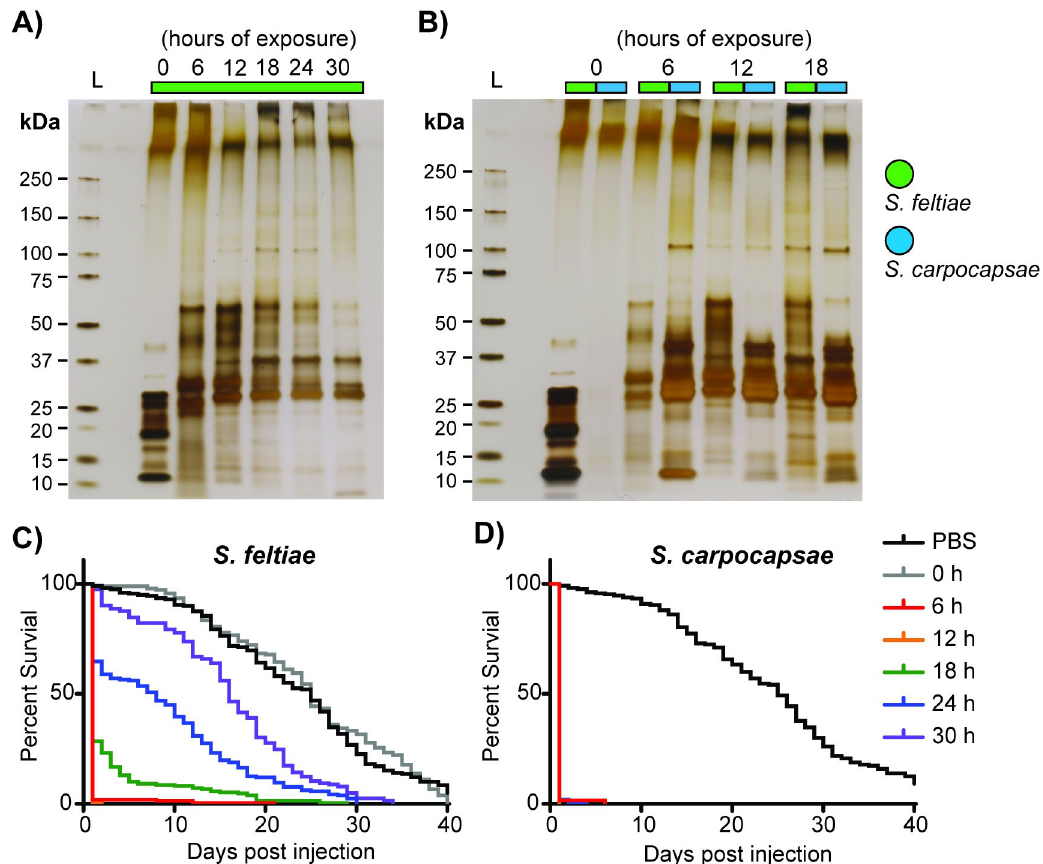
Fig 2. Steinernema IJs release toxic proteins. (A) Silver stained protein gel of whole ESPs collected from S . feltiae IJs activated for 0 (non-exposed), 6, 12, 18, 24, and 30 hours in insect homogenate. All time course activations were done with approximately 2.5 million IJs and the collected ESPs were concentrated to the same volume (300 μ l) and the same volume (3 μ l) was loaded to each lane. (B) Silver stained protein gel of whole ESPs (1 μ g) from S . feltiae (green) and S . carpocapsae (blue) activated for 0, 6, 12, and 18 hours. (C) Survival curves of flies injected with 20 ng of whole ESPs from S . feltiae . (D) Survival curves of flies injected with 20 ng of whole ESPs from S . carpocapsae ( S . carpocapsae survival curve was recapitulated from Lu. et al, 2017). Each survival curve includes 3 or more biological replicates totaling at least 180